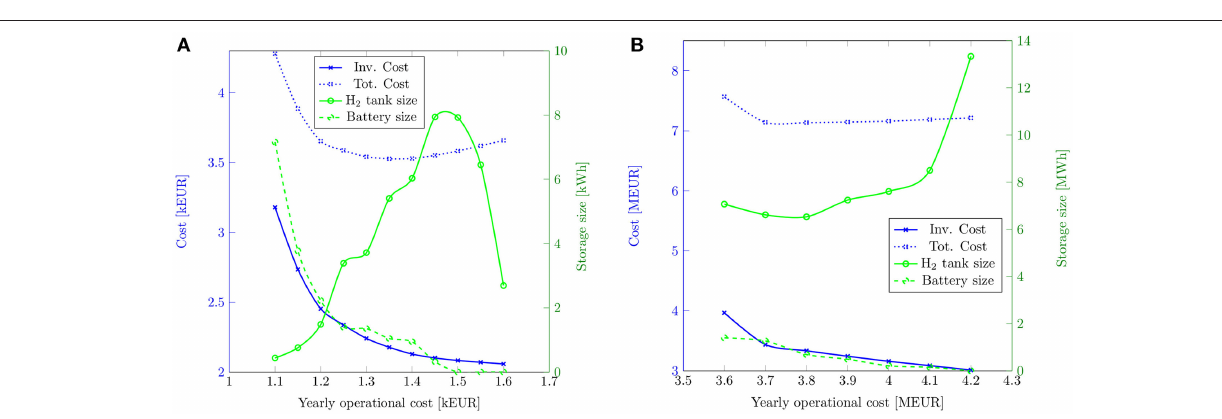
Frontiers in Energy Research |